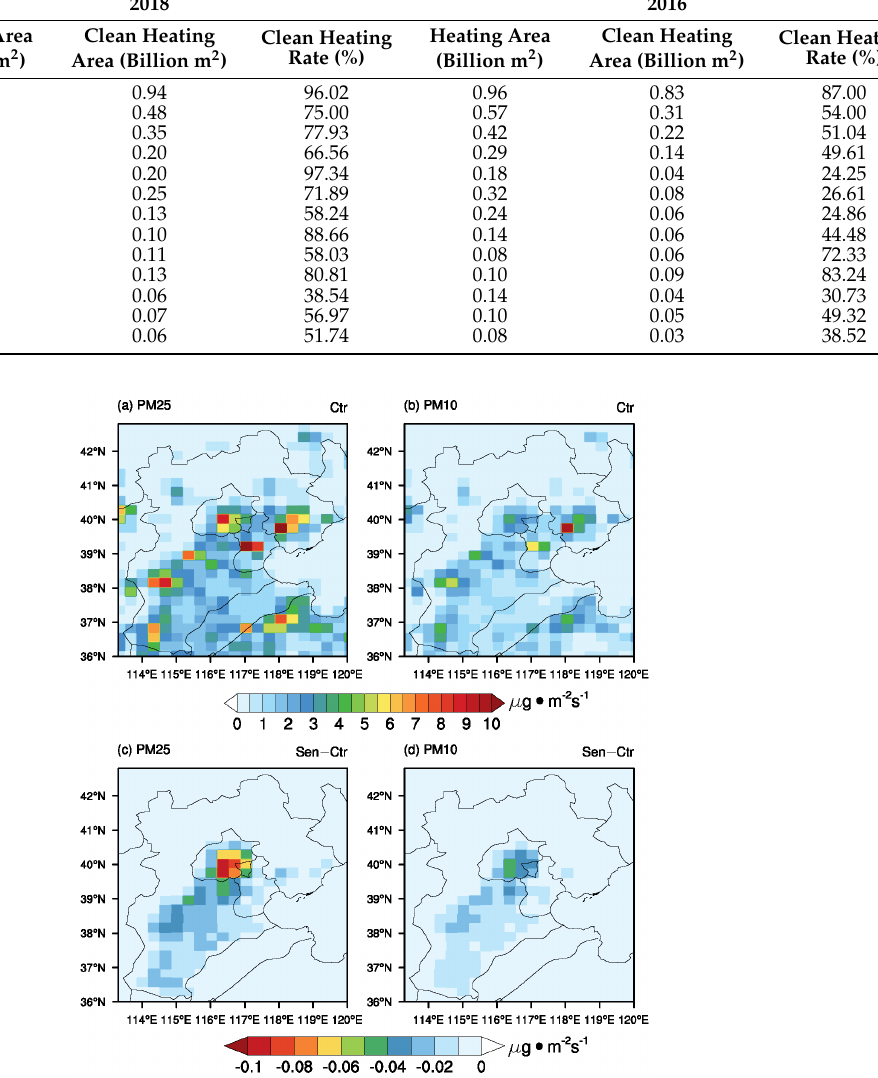
Figure 2. The spatial distribution of ( a , c ) PM 2 . 5 and ( b , d ) PM 10 emission intensity (units: μ g/m 2 s) in the inner domain for ( a , b ) the baseline simulation and ( c , d ) the mitigated counterparts (units: μ g/m 2 s) due to the implementation of CTGC and CTEC projects from 2016 to 2018. Table 1. Statistical results of heating and clean heating areas in 2016 and 2018 for the BTH region, and the residential coal-mitigation rate due to CTGC/CTEC projects.